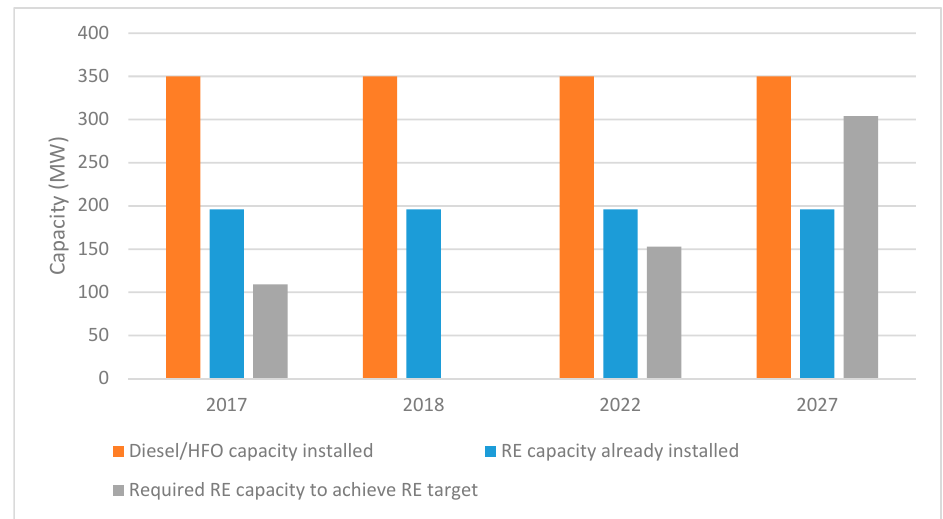
Figure 5. Installed and required power capacities to achieve the RE targets.